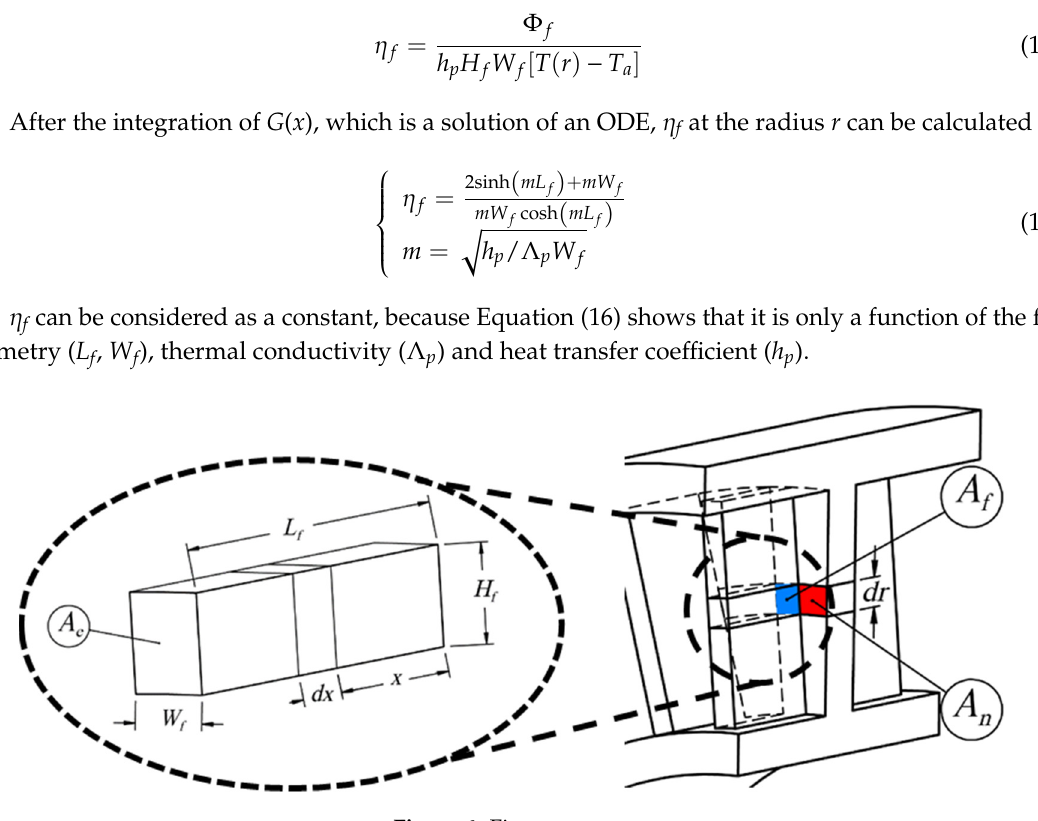
Figure 6. Fin geometry.